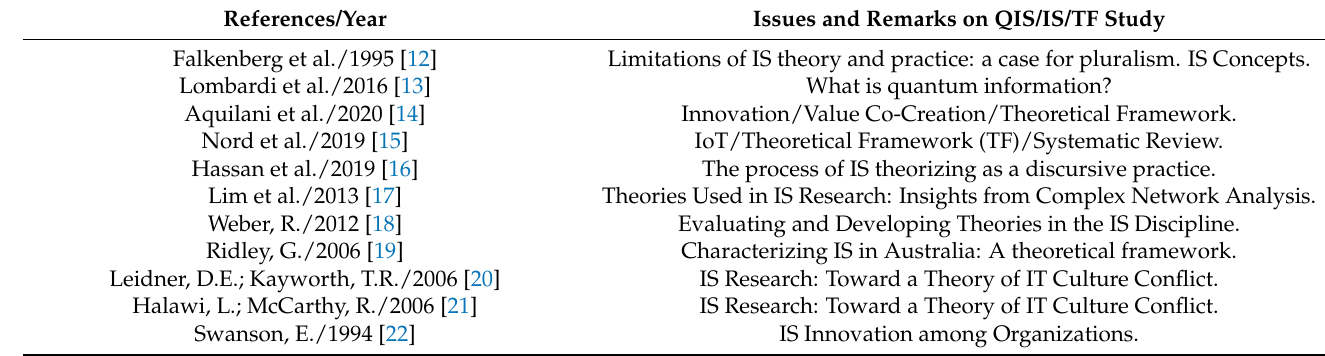
Table 1. Summary of the literature review on IS/ Quantum Information Systems (QIS) and theoretical